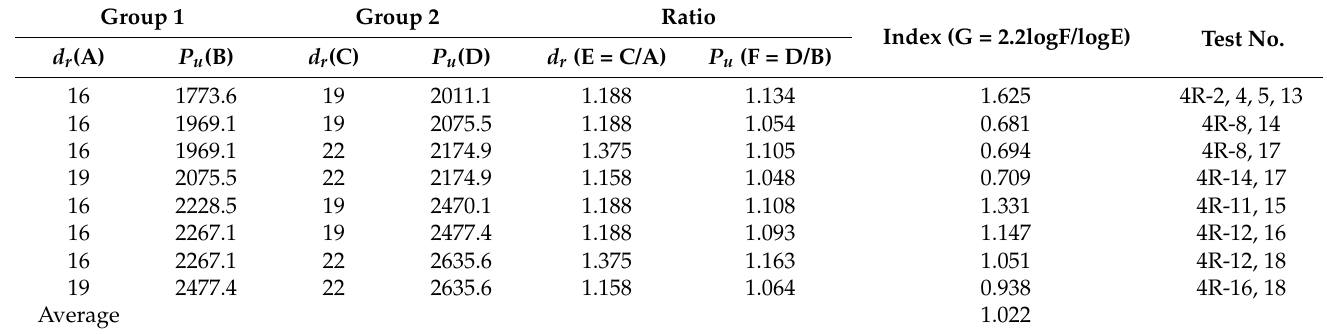
Table 10. Index value for the variable of d r .